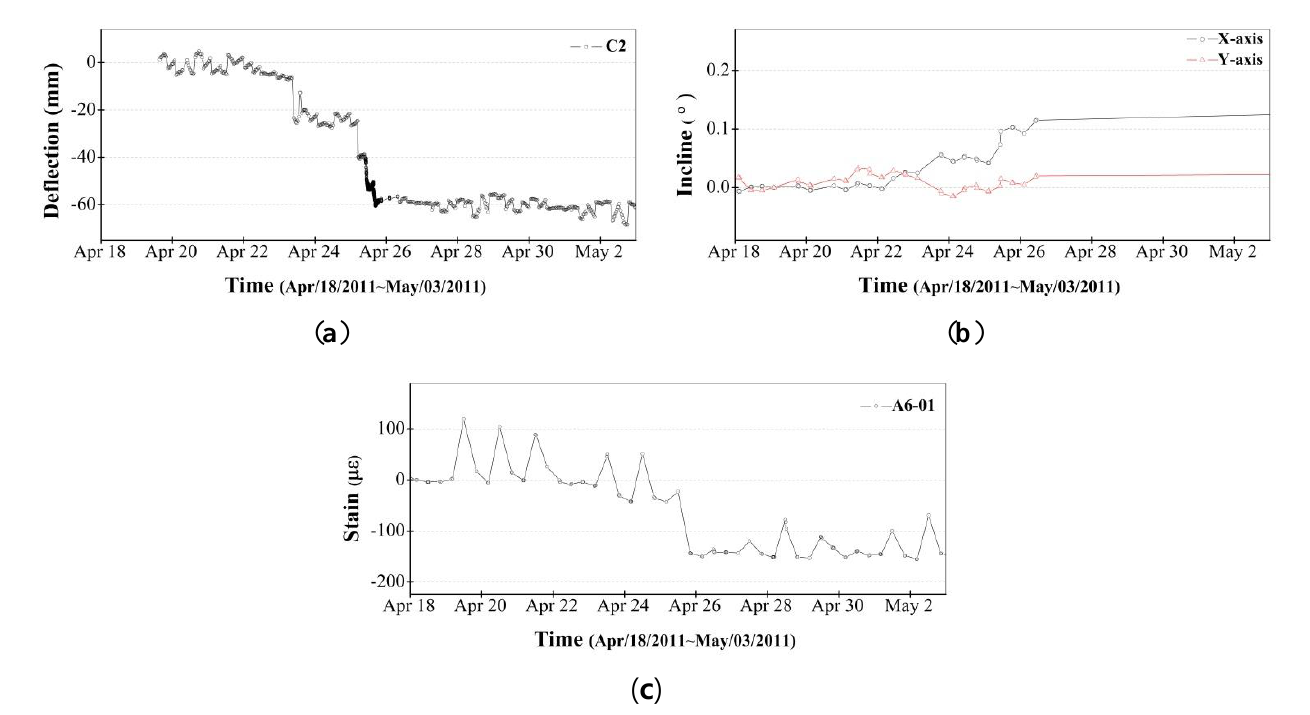
Figure 13. Terms of bent removal. ( a ) Deflection in zone C2; ( b ) Inclination in zone C3; ( c ) Strain data in zone